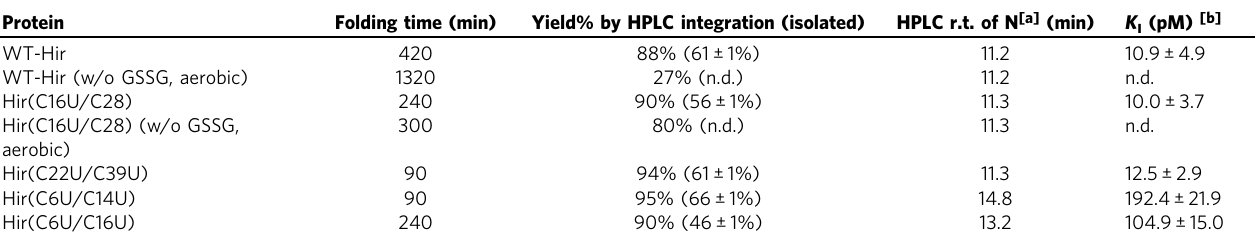
Table 1 Characterization of WT-Hir and the Se-Hir analogues.